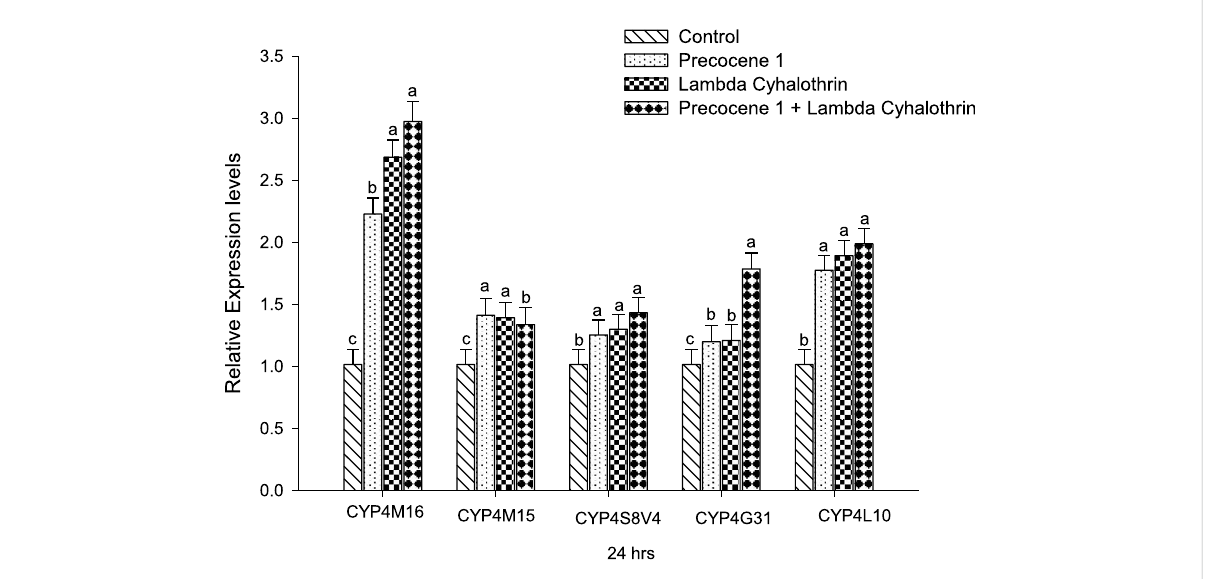
FIGURE 5 Effect of Precocene 1 on Spodoptera litura larvae tolerance to λ -cyhalothrin and relative expression levels of cytochrome P450s genes after 24 h. The transcription levels of three cytochrome P450s genes are determined by quantitative real-time PCR, normalized to different genes. Each bar indicates the mean of transcription levels (±SE), each being replicated. Different letters above bars indicate signi fi cant differences ( p < 0.05) according to the Tukey HSD